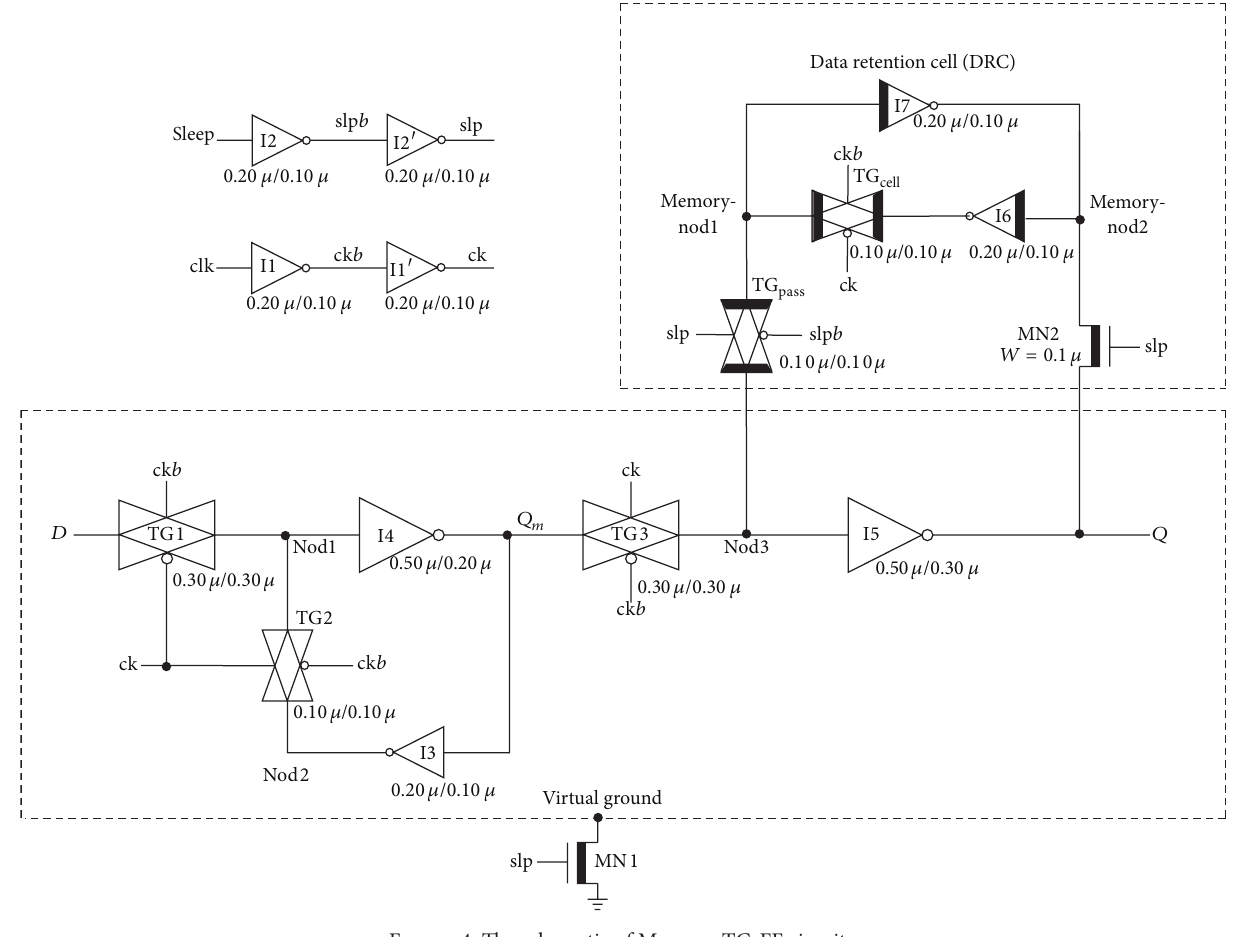
Figure 4: The schematic of Memory-TG-FF circuits.